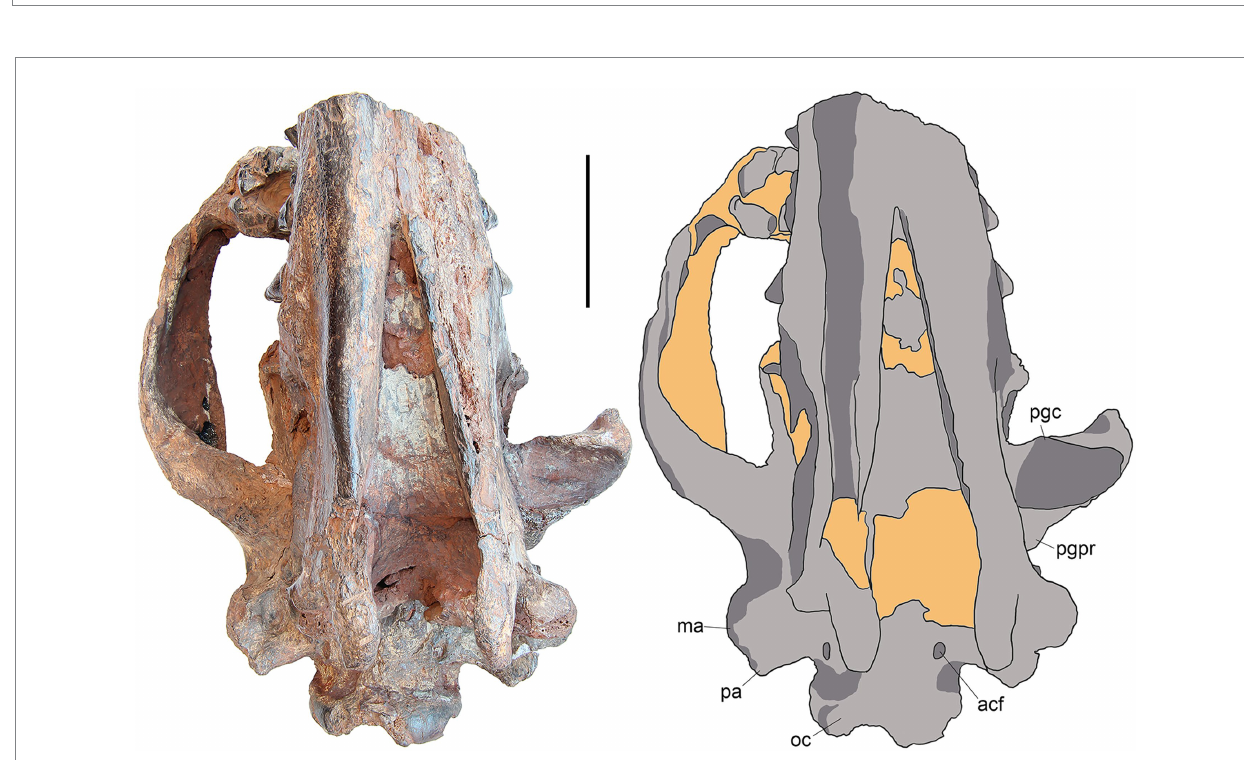
FIGURE 3 M. peregrinus , gen. et sp. nov., SYSU-M-5, holotype, a partial skull with associated mandibles in ventral view (photograph and explanatory drawing). Youganwo Formation, upper Eocene, Maoming locality, Guangdong Province, China. acf, anterior condyloid foramen; ma, mastoid apophysis; oc, occipital condyle; pa, paroccipital apophysis; pgc, preglenoid crest; pgpr, postglenoid process. Scale bar equals 5 cm.